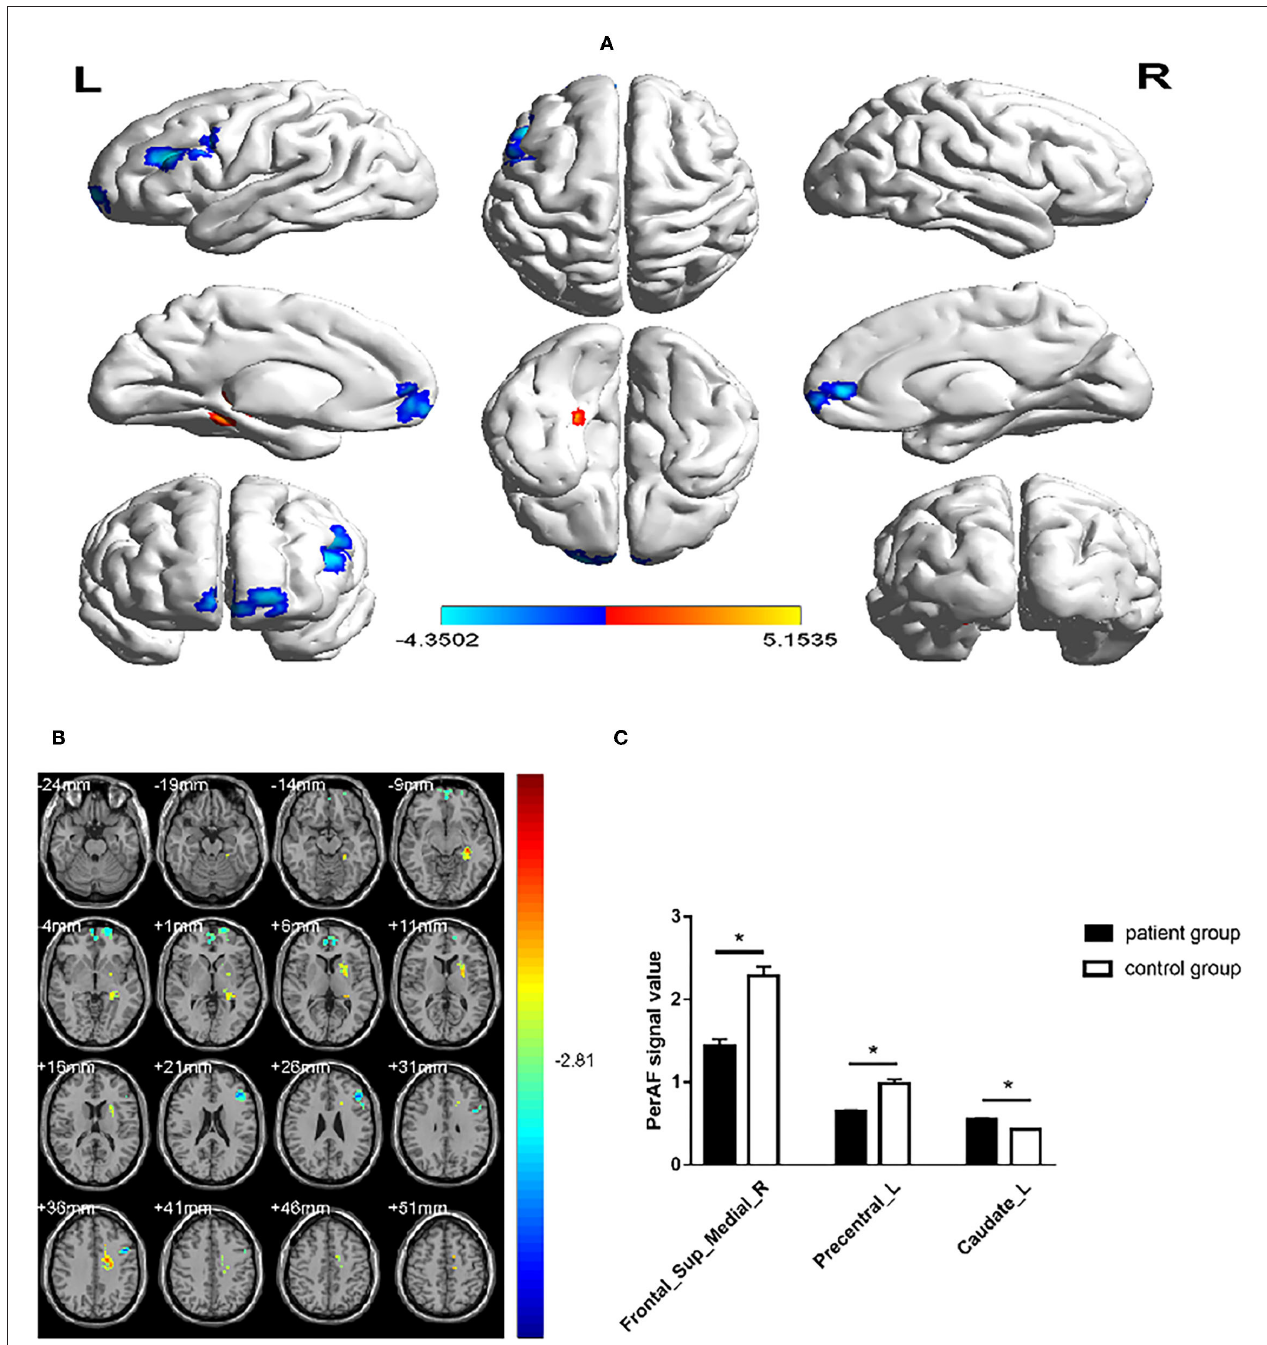
FIGURE 2 | Comparison of the PerAF signal in patients with MMD and HCs. (A,B) Green and orange represent the signal strength. The PerAF value in Frontal_Sup_Medial_R and Precentral_L was decreased, while the PerAF value was increased in Caudate_L (the AlphaSim correction was performed at cluster size > 103 voxels, p < 0.005). (C) The mean PerAF values in the 2 groups. MMD, moyamoya disease; PerAF, percent amplitude of fluctuation; HC, healthy control. * P < 0.05.